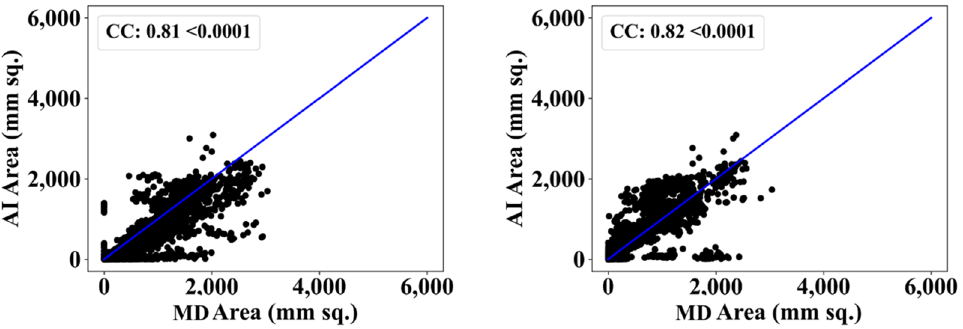
Figure 23. Correlation coefficient plots for ( left ) ResNet-UNet vs. MD 1 and ( right ) ResNet-UNet vs. MD 2.